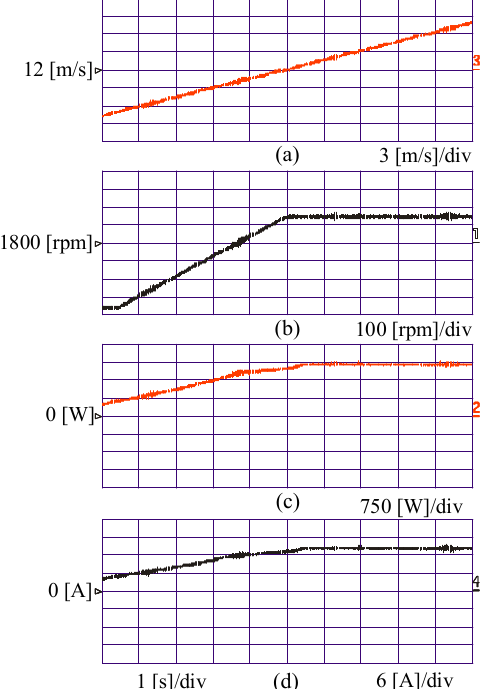
Energies 2017 , 10 , x FOR PEER REVIEW Figure 22. DFIG currents after synchronization: ( a ) Stator currents, ( b ) rotor currents.